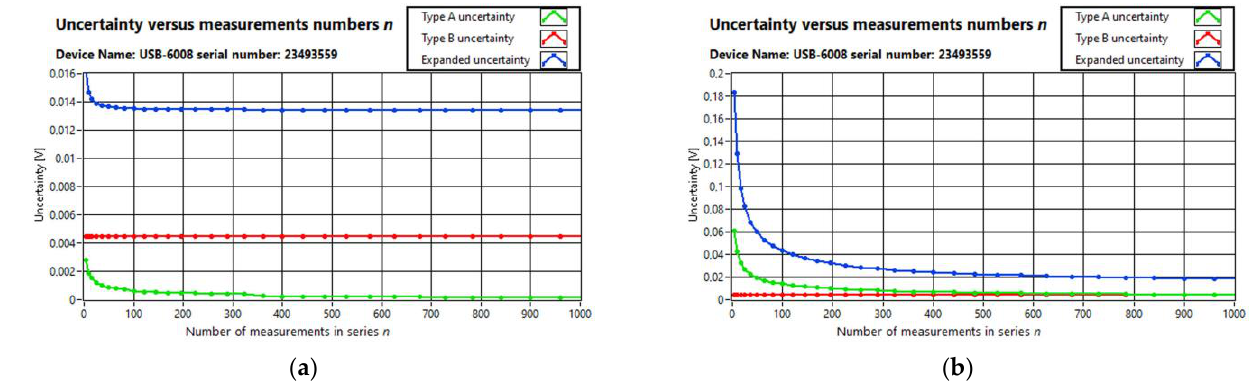
Figure 9. Uncertainties obtained from the measurements for the tested module NI USB-6008: ( a ) at low interference level, ( b ) at high interference level.